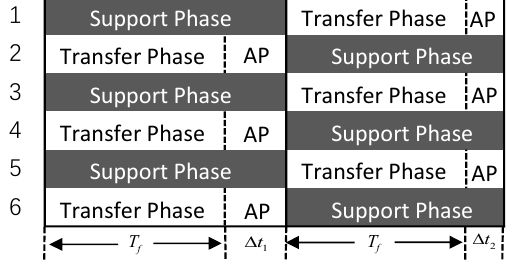
Figure 11. Triangle gait designed in